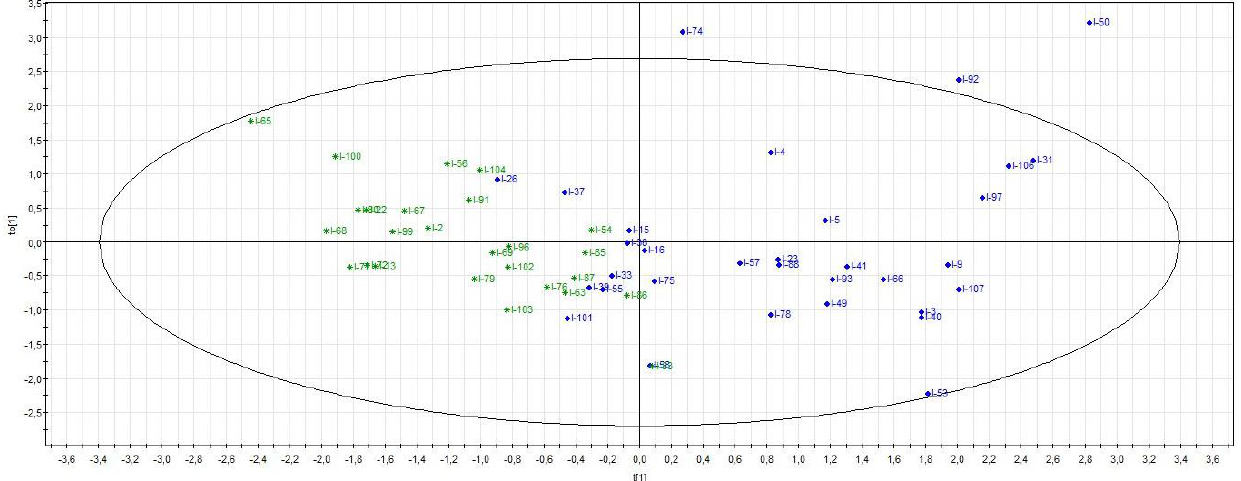
Figure 2. Scores plot (septic shock versus ICU control group). Septic shock patients (in blue) versus ICU control patients (in green). The supervised OPLS-DA method shows a significant difference between septic shock patients and ICU control patients (CV-ANOVA, p = 0.006).